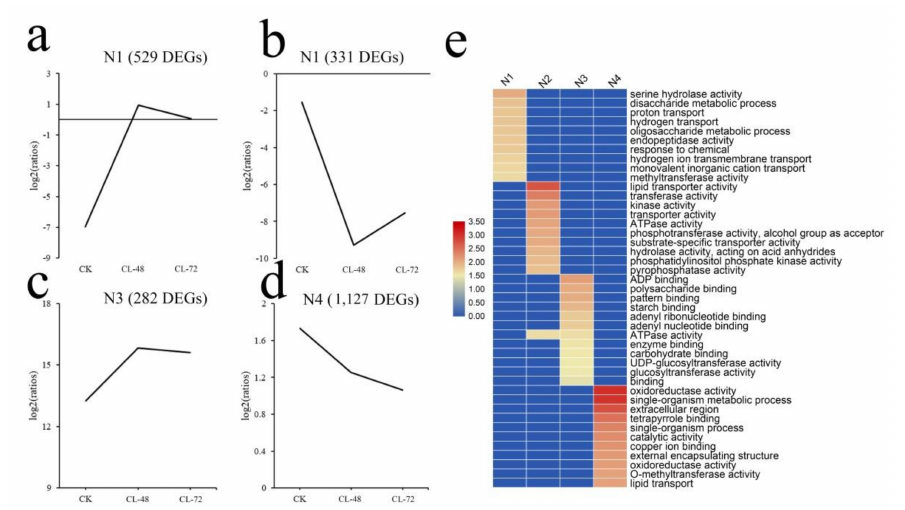
Figure 3. Clustering analysis of the DEGs. ( a ) The results for the N1 cluster. ( b ) The results for the N2 cluster. ( c ) The results for the N3 cluster. ( d ) The results for the N4 cluster. ( e ) Heat map of the GO annotations for each